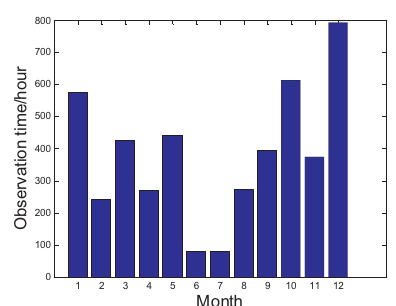
Fig. 1 The distribution of cumulative observation hours in each month of the broadband Na lidar of Yanqing Station, Beijing during the period of May, 2014 (cid:8) December,